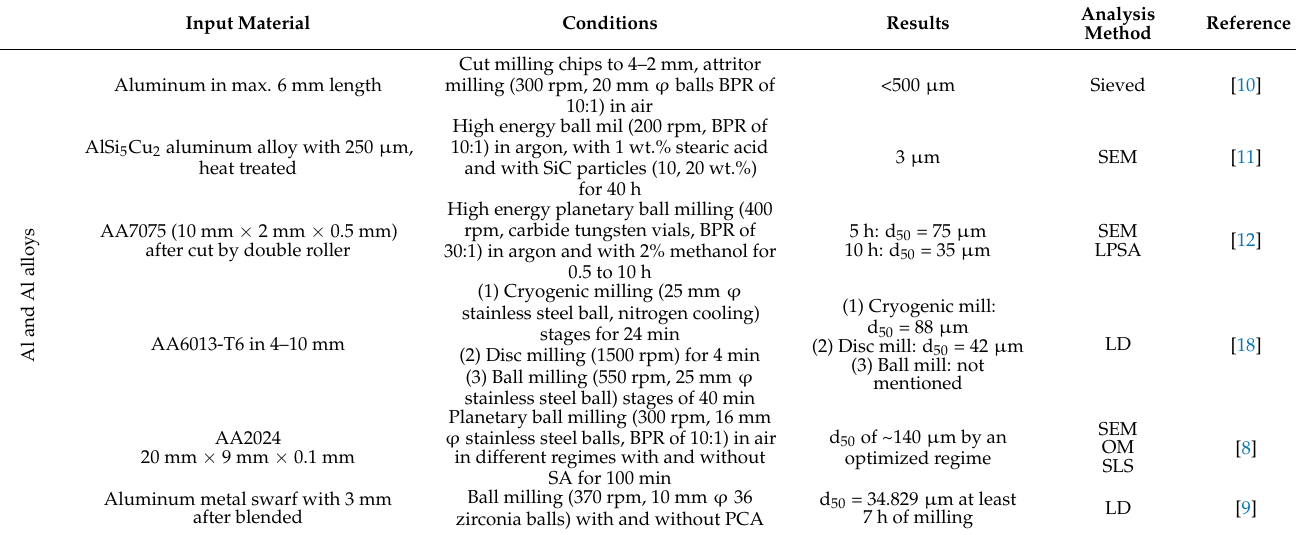
Table 1. Milling of different material